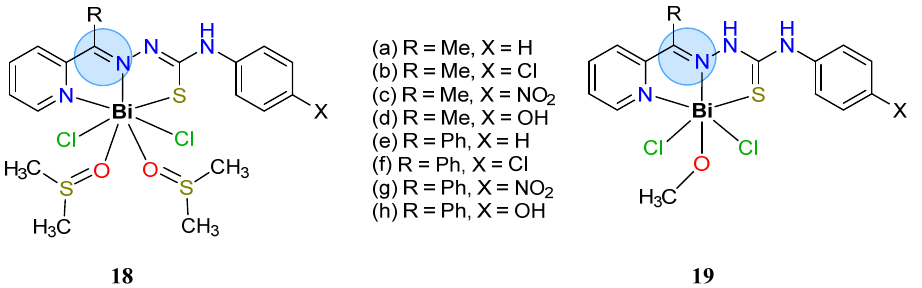
Figure 10. Bismuth(III) complexes with 2 ‐ acetylpyridine ‐ and 2 ‐ benzoylpyridine ‐ derived hydra ‐ zones ligands studied in antimicrobial activity.